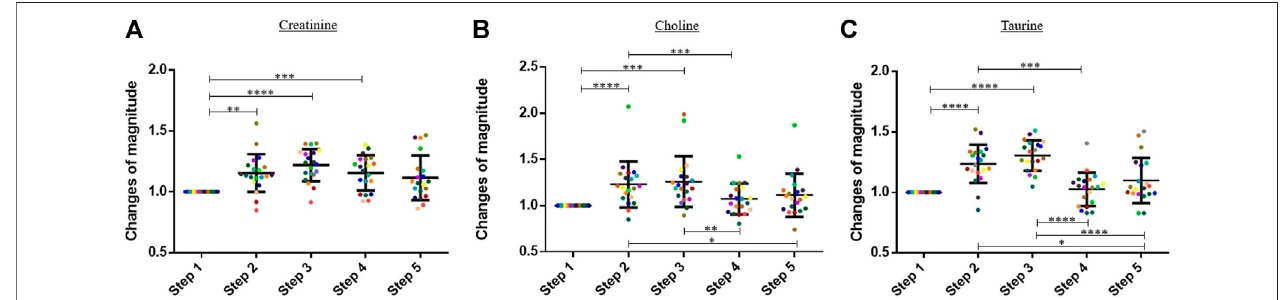
FIGURE 2 | Graphs representing the “ changes of magnitude ” obtained during the fi ve steps of the study. Step 1: before physical exercise, step 2: after 400-m warm-up and 800-m running, step 3: after the completion of 1,600-m running, step 4: 30 min after fi nishing the exercise, and step 5: 60 min after fi nishing the exercise. Each color represents oneparticipant. Black lines representthe mean ± SD ofthe change ofmagnitude factor obtained at each step( n (cid:2) 20). (A) Creatinine, (B) choline, (C) taurine: amino acids for which an increase in blood concentration was observed during the exercise (*, p -value < 0.05; **, p -value < 0.01; ***, p -value < 0.001; ****, and p -value < 0.0001).